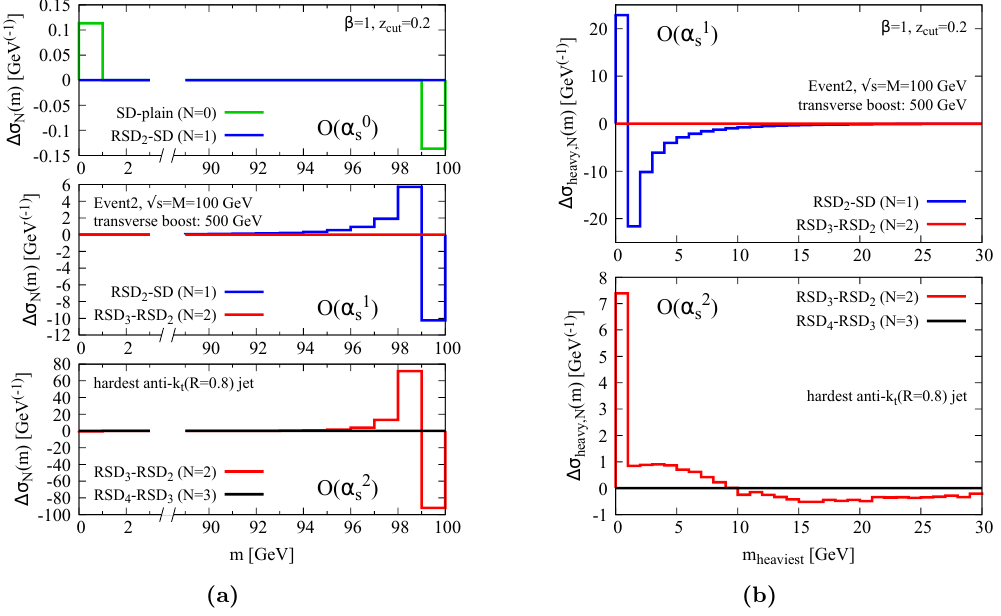
Figure 14. Fixed-order coe(cid:14)cients from Event2 for (a) the jet mass distribution and (b) the heavier subjet mass distribution. The plot shows eq. (A.1), the di(cid:11)erence in the jet mass spectrum obtained with consecutive layers of